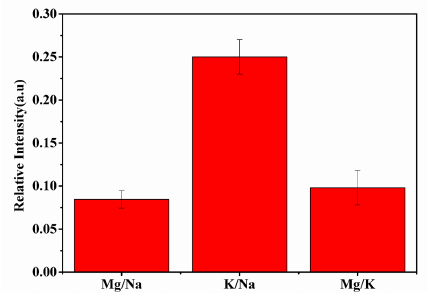
Figure 3. Intensity ratios Mg/Na, K/Na, and Mg/K of t. dioica